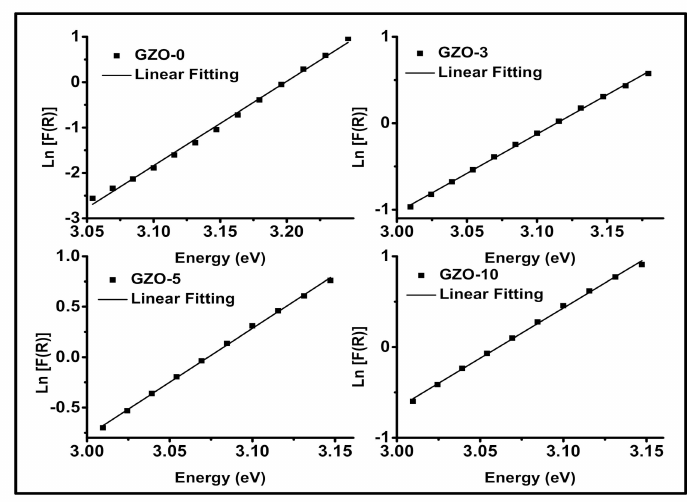
Figure 11. Plot of ln [ F ( R )] versus Energy = h ν for the investigated Ga-doped ZnO